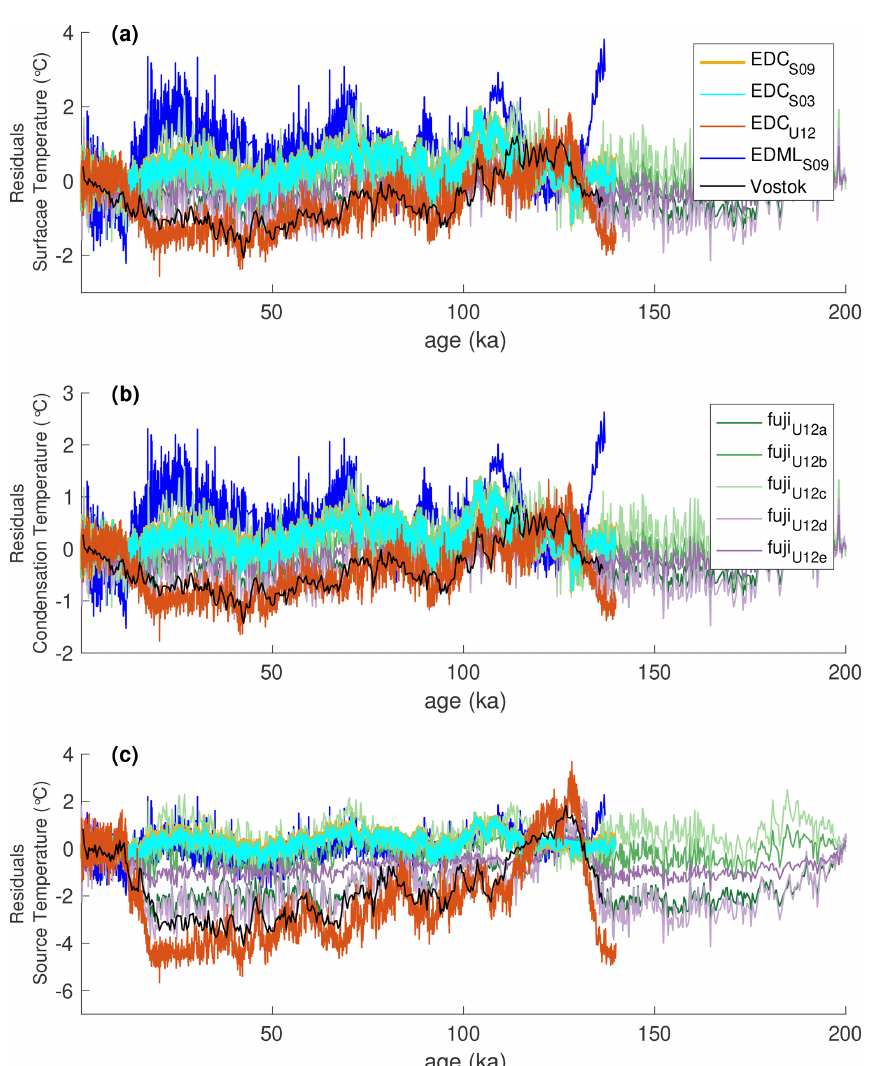
Figure 12. Differences between our full nonlinear reconstruction and multiple previously published linear reconstructions (Stenni et al., 2004, 2010; Uemura et al., 2012) of (a) ice-core site surface temperature, (b) site condensation temperature, and (c) evaporation source temperature for multiple core sites. Full reconstructions are shown in Fig.